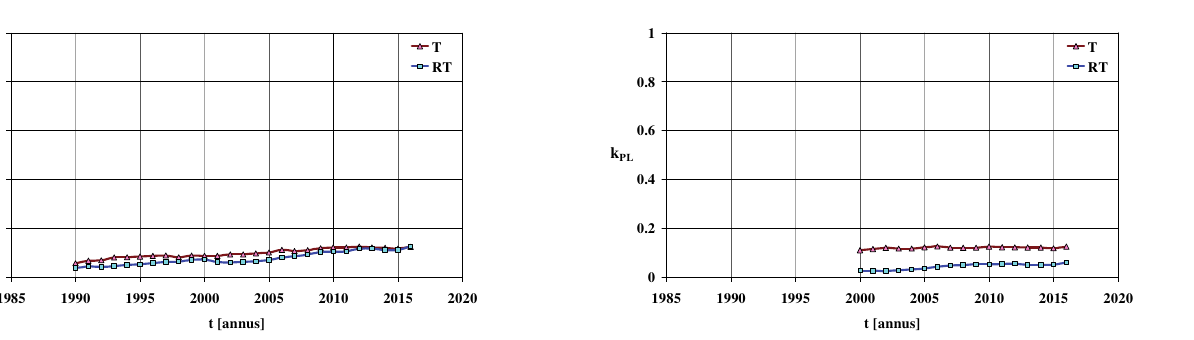
Fig. 11. Share of annual emission in Poland comparing to the annual emission in the European Union for particulate matter PM10: for total emission – T and for emission from motor vehicles – RT in years 1990–2016